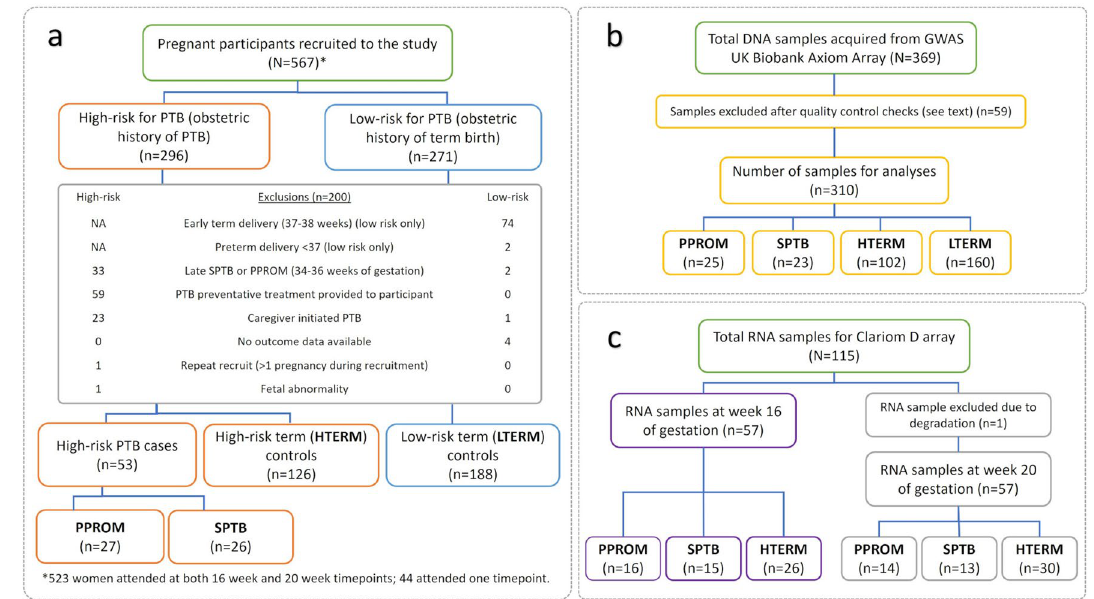
Figure 1. Singleton pregnant participants recruited to the Liverpool preterm birth study cohort. ( a ) Final number of women included in the analyses. ( b ) DNA was extracted from whole blood collected from the participants and genomic profiling (GWAS) was conducted on the Biobank Axiom™ array. ( c ) RNA extracted from whole blood collected from participants at 16 and/or 20 weeks of gestation was processed on the